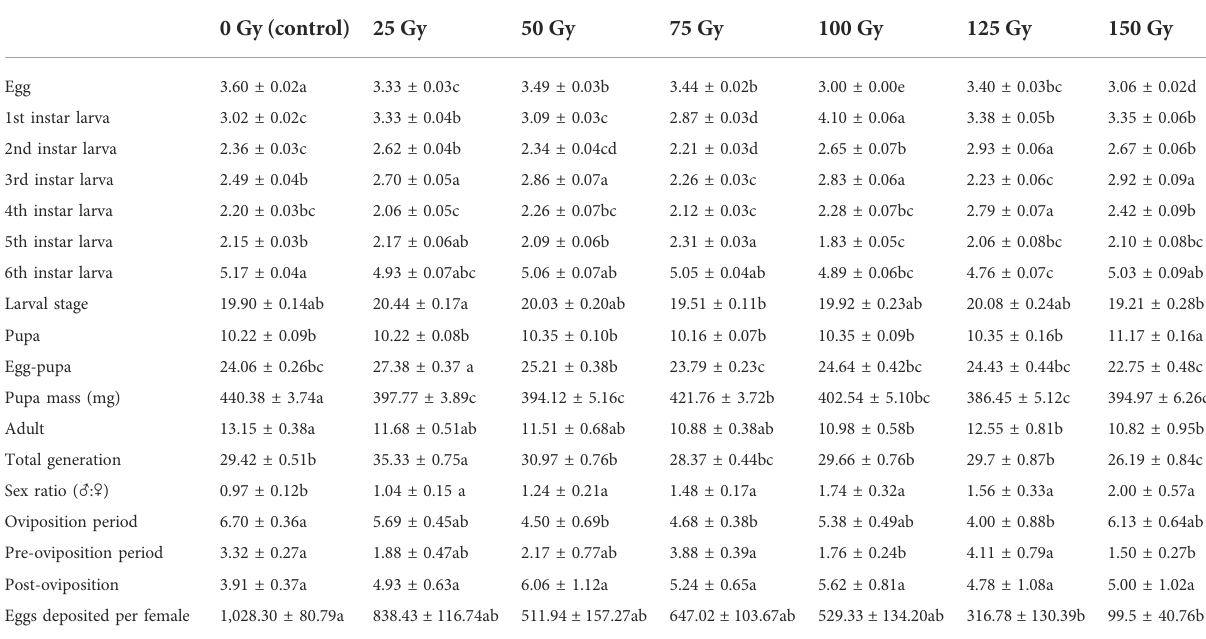
TABLE 3 Mean duration (±SE) for developmental stages of F 1 generation of Spodoptera litura after male parent was irradiated with different X-ray doses during pupal stage. Developmental stage Developmental duration